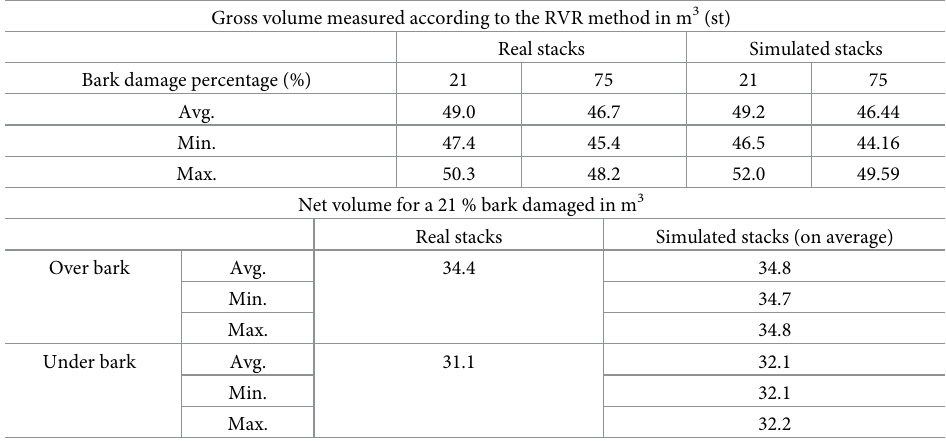
Table 1. Basic descriptive statistics of the simulation results and performed measurements of real stacks. Gross volume measured according to the RVR method in m 3 (st) Real stacks Simulated stacks Bark damage percentage (%)